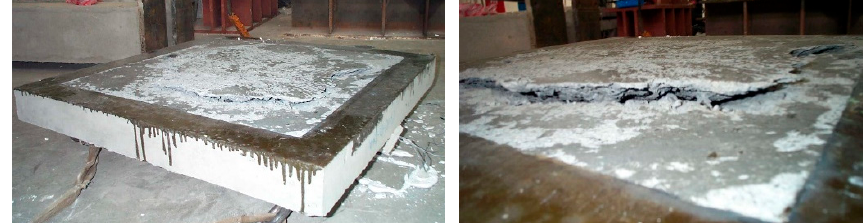
Figure 6. Punching shear failure on the tension surface of the specimen CSR1-C2-F2 after peeled off the CFRP laminates.